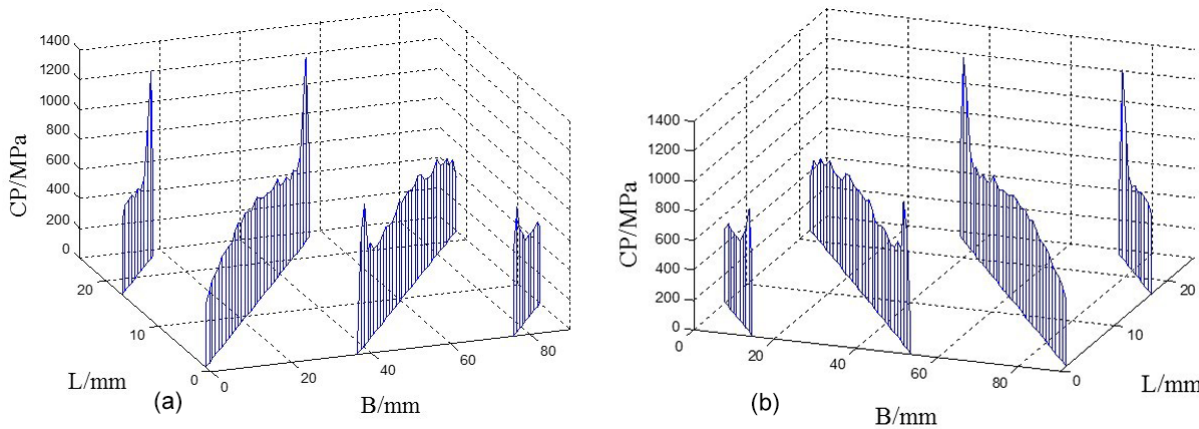
Figure 20. Contact stress distribution of the tooth surface with the stiffness of the no. 5 shaft section. (a) Left tooth surface. (b) Right tooth surface.